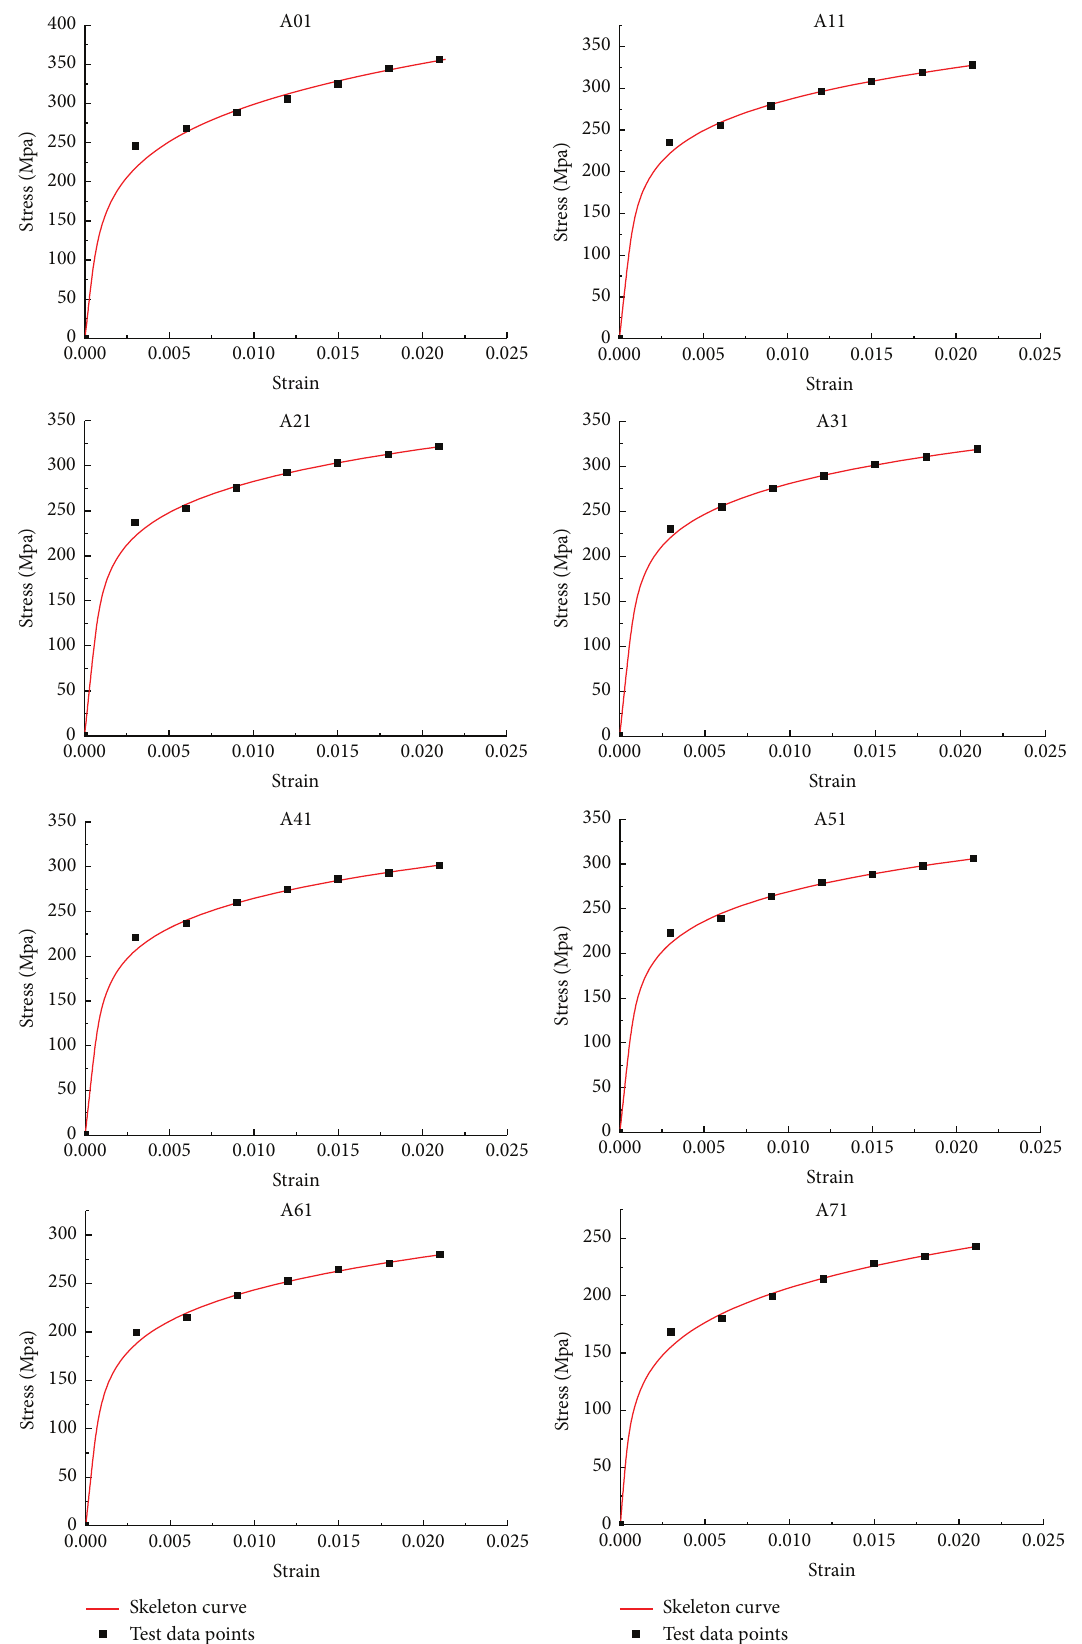
Figure 6: Fitting curve of skeleton